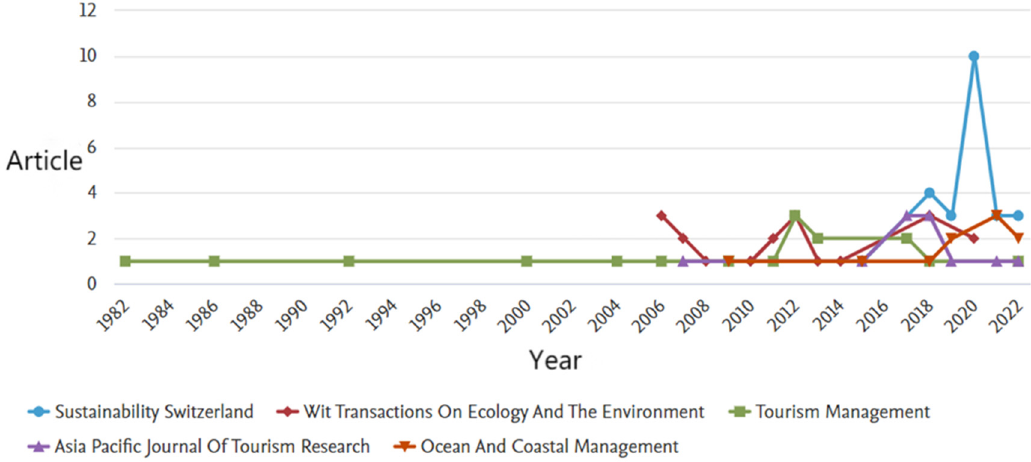
Figure 2. Top 5 journals in terms of articles on the TECC.